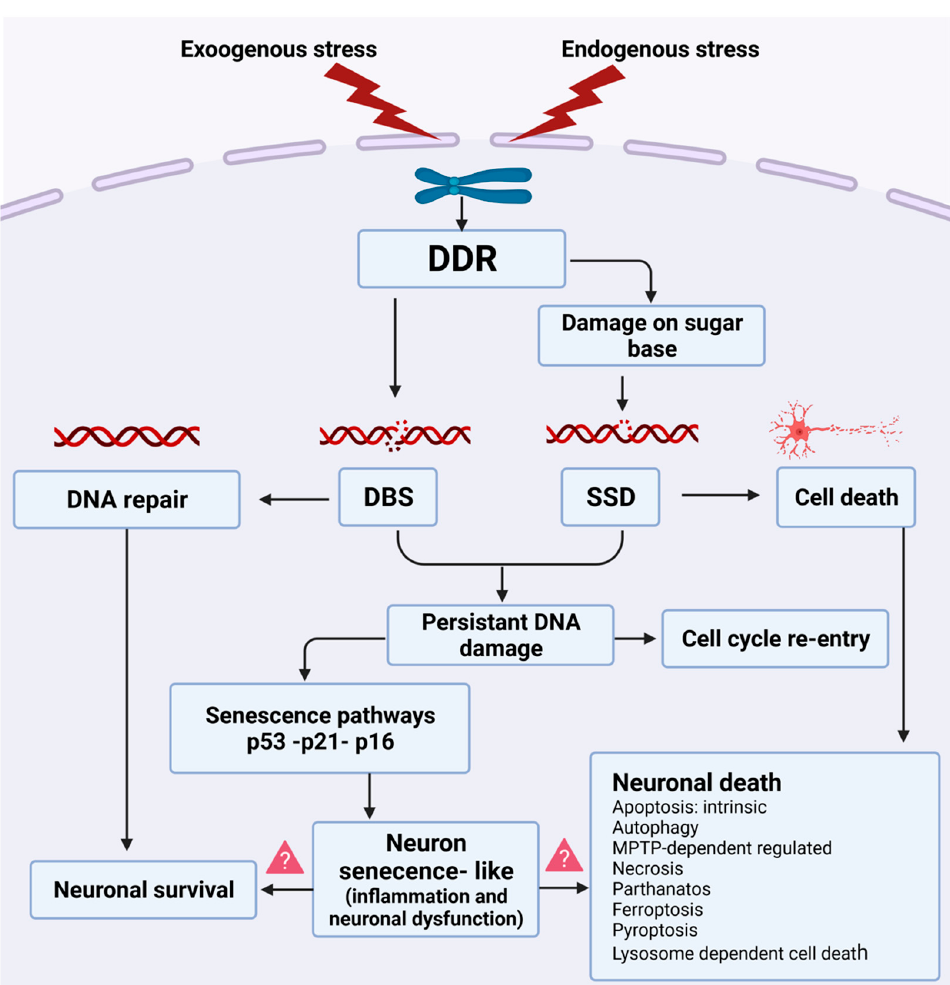
Figure 3. The complex interplay between the DDR and different outcomes in neurons. Neurons are exposed to both endogenous and environmental/exogenous sources of DNA damage. The DDR recognizes the damage and activates downstream factors, resulting in distinct outcomes depending on the damage. This includes several key proteins that contribute through diverse pathways to mediate either survival or RCD. The figure depicts those RCD pathways induced by DNA damage amongst the numerous cell death pathways now identified. As the DDR requires intervention of multiple pathways to maintain the integrity of the genome, the interplay between different cell death pathways is complex and difficult to discern. Thus, a deeper understanding of how the DDR induces neuronal death may lead to new therapeutic opportunities in neurodegenerative diseases to prevent or delay the loss of neurons [387,388].